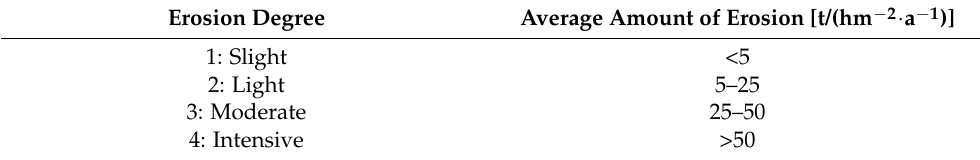
Table 1. Classes of soil erosion